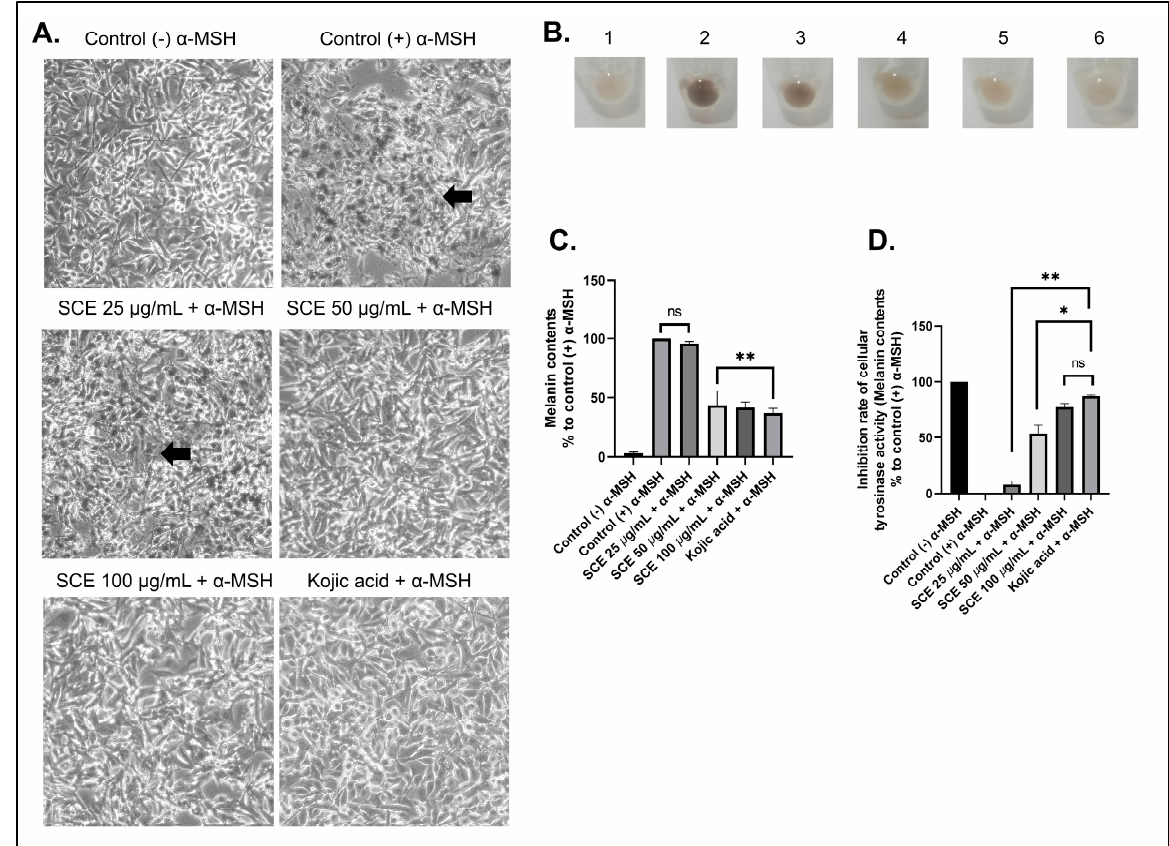
Figure 3. The B16-F10 cells were treated with α -MSH to induce melanin production. ( A ) Morpho- logical observations showing the normal cell morphology of cells treated with α -MSH and SCE. ( B ) Harvested cell pellets of α -MSH-treated cells with SCE. ( C ) Melanin content analyses of α -MSH- treated cells with SCE. ( D ) Tyrosinase activity inhibition in α -MSH-treated cells with SCE. The results are represented as the means of three independent experiments (SEM ± SD). * Indicates signifi- cant difference between treatments ( p < 0.05). ** indicates a highly significant difference between treatments ( p < 0.01). Black arrows indicate melanin production. ns indicates no significant differ- ence.